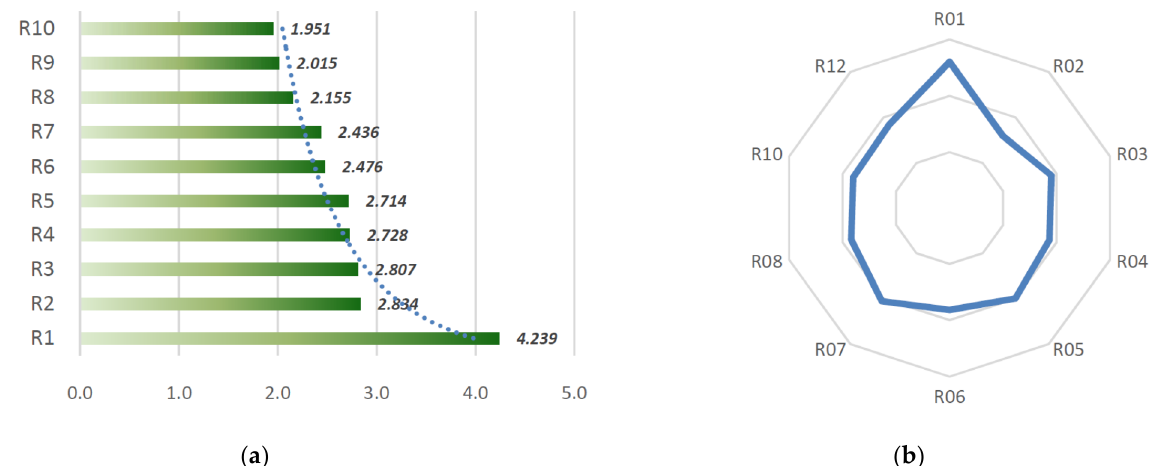
Figure 4. ( a ) Overall top 19 most effective risks, ( b ) Top 10 risks for cost objective.